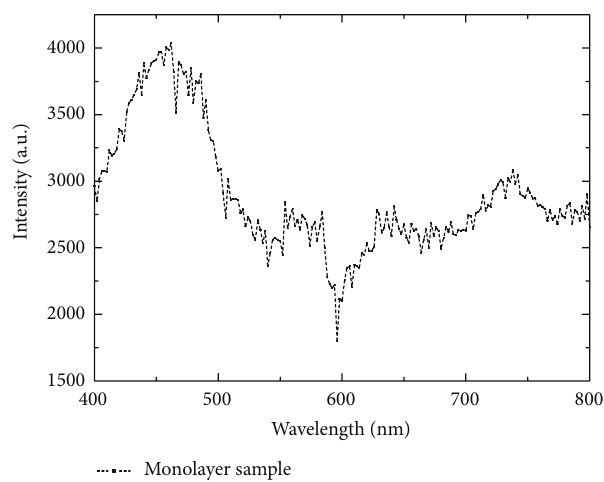
Figure 6: Photoluminescence emission spectra of monolayer sam- ple at 250